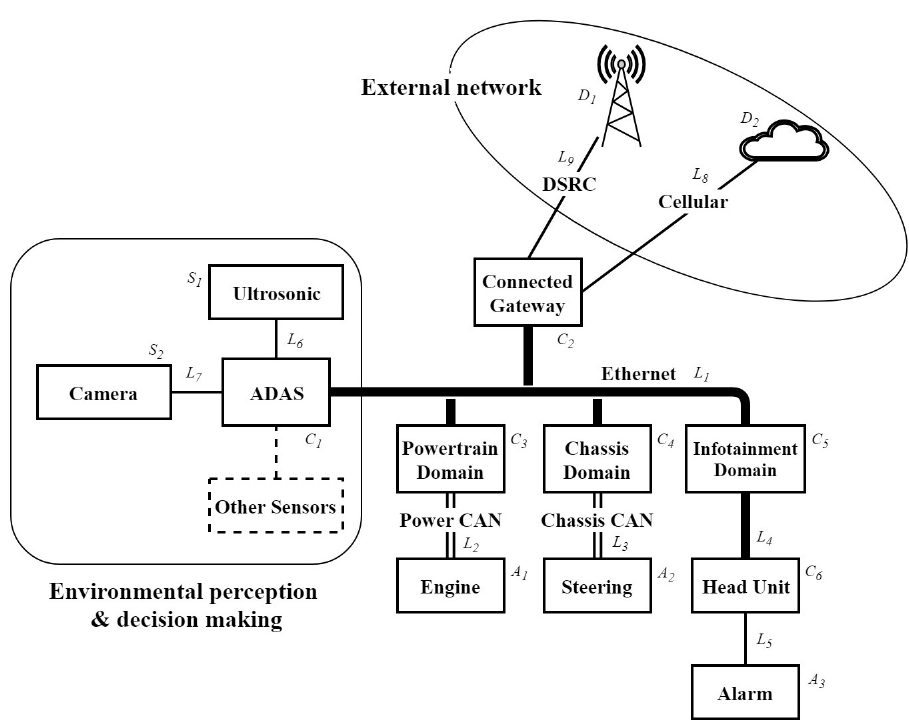
Figure 5. Collision warning system based on centralized EEA.